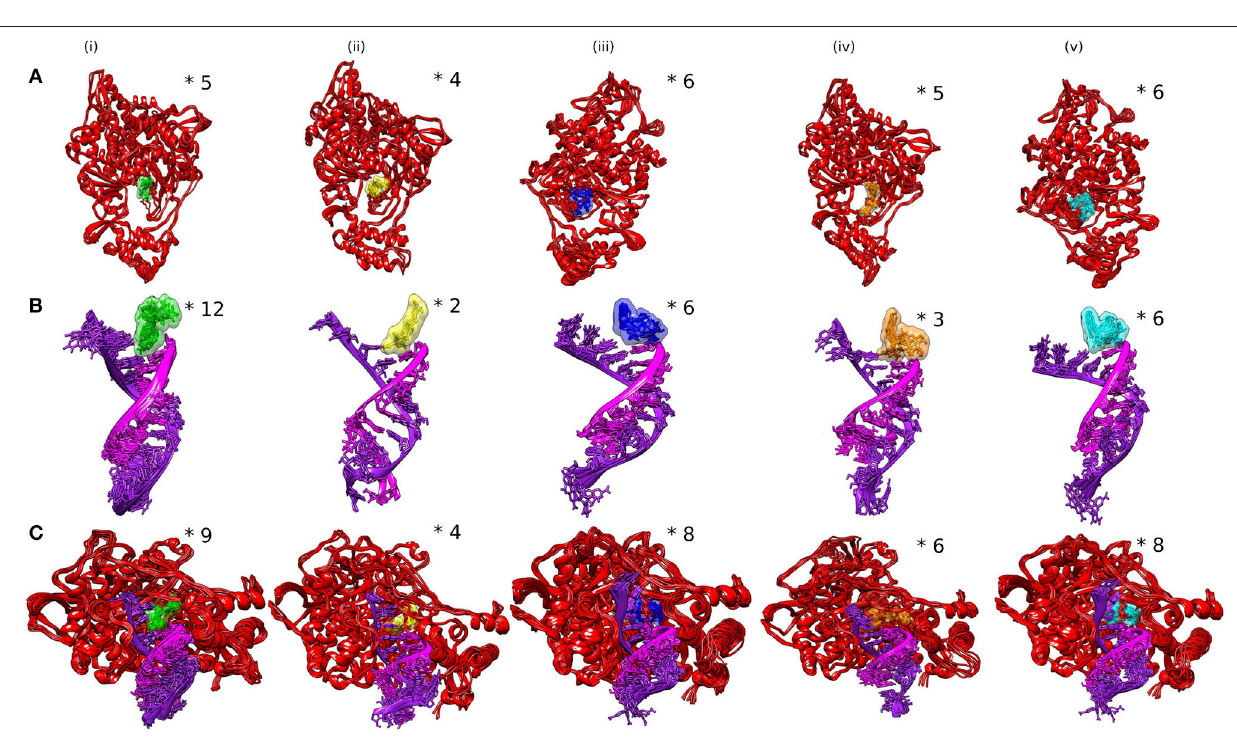
site RNA ( Figure 5B ). The standard drugs Remdesivir and Favipiravir were able to form an average of one and two hydrogen bonds, respectively, with the active site RNA. All the three